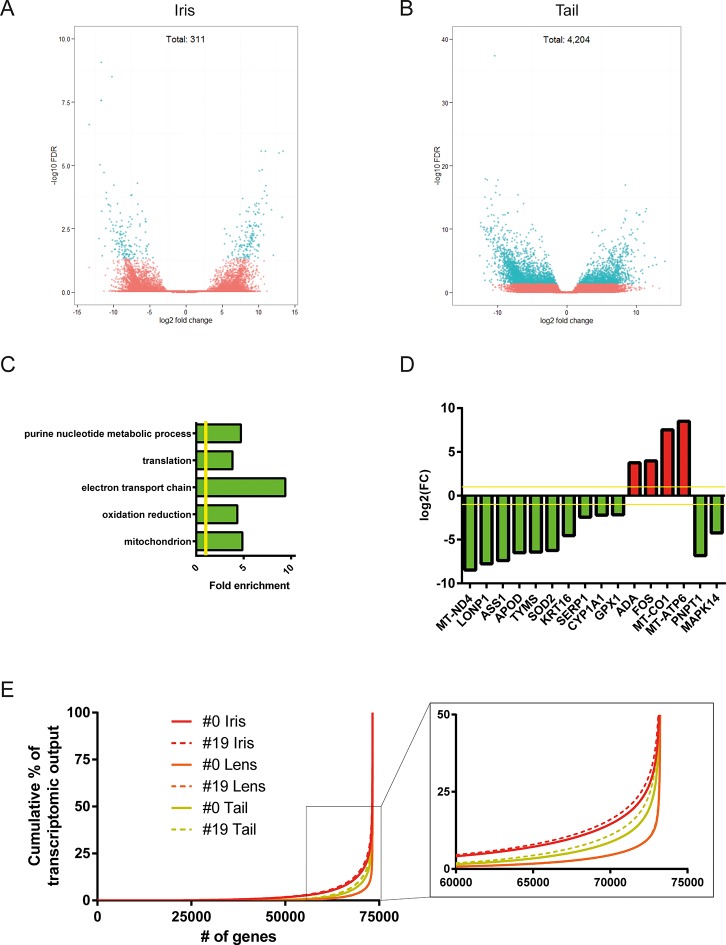
Differential gene expression between #19 and #0 tissues.(A) Volcano plot for the #19 versus #0 iris samples. (B) Volcano plot for the #19 versus #0 tail samples. Differentially expressed genes (false discovery rate [FDR]<0.05 and fold change [FC]>2) are depicted in cyan. Tail samples, which never experienced regeneration, showed the most differentially expressed genes. Iris samples, which as the source of lens regeneration have experienced some degree of regeneration/replenishment, showed a reduced number of differentially expressed genes and an intermediate ageing profile. (C) Selected enriched (FDR <0.05) Gene Onthology (GO) terms in tail samples plotted based on their fold enrichment. Green-colored bars mark gene groups that are down-regulated in the #19 samples. Yellow line marks fold enrichment of 1. Electron transport chain is one of the functional group enriched in the down-regulated group, a well-documented ageing signature in other vertebrates. (D) Genes selected for their role in ageing and/or senescence and plotted based on their fold change between #19 and #0 tail samples. Green and red bars mark down-regulated or up-regulated genes in #19 samples, respectively. Yellow line marks log2(FC) of 1. These data provide additional evidence of ageing signs in our #19 tails samples. (E) Transcriptomic complexity between #0 and #19 tissues. Red, orange, and yellow denotes iris, lens, and tail samples, respectively. Solid and dotted lines represent tissues from #0 and #19 newts, respectively. In this graph, genes were sorted based on their expression and plotted based on their cumulative percent contribution to the overall transcriptomal output. Iris had the most complex transcriptome by having more genes contributing to the overall output (steeper line), followed by the tail and lens. Tissues from #19 newts showed slightly increased transcriptomic complexity versus their #0 counterparts (enlarged insert). Lens showed the least increase in complexity which further supports that lens regeneration is a robust process that can faithfully proceed throughout life.